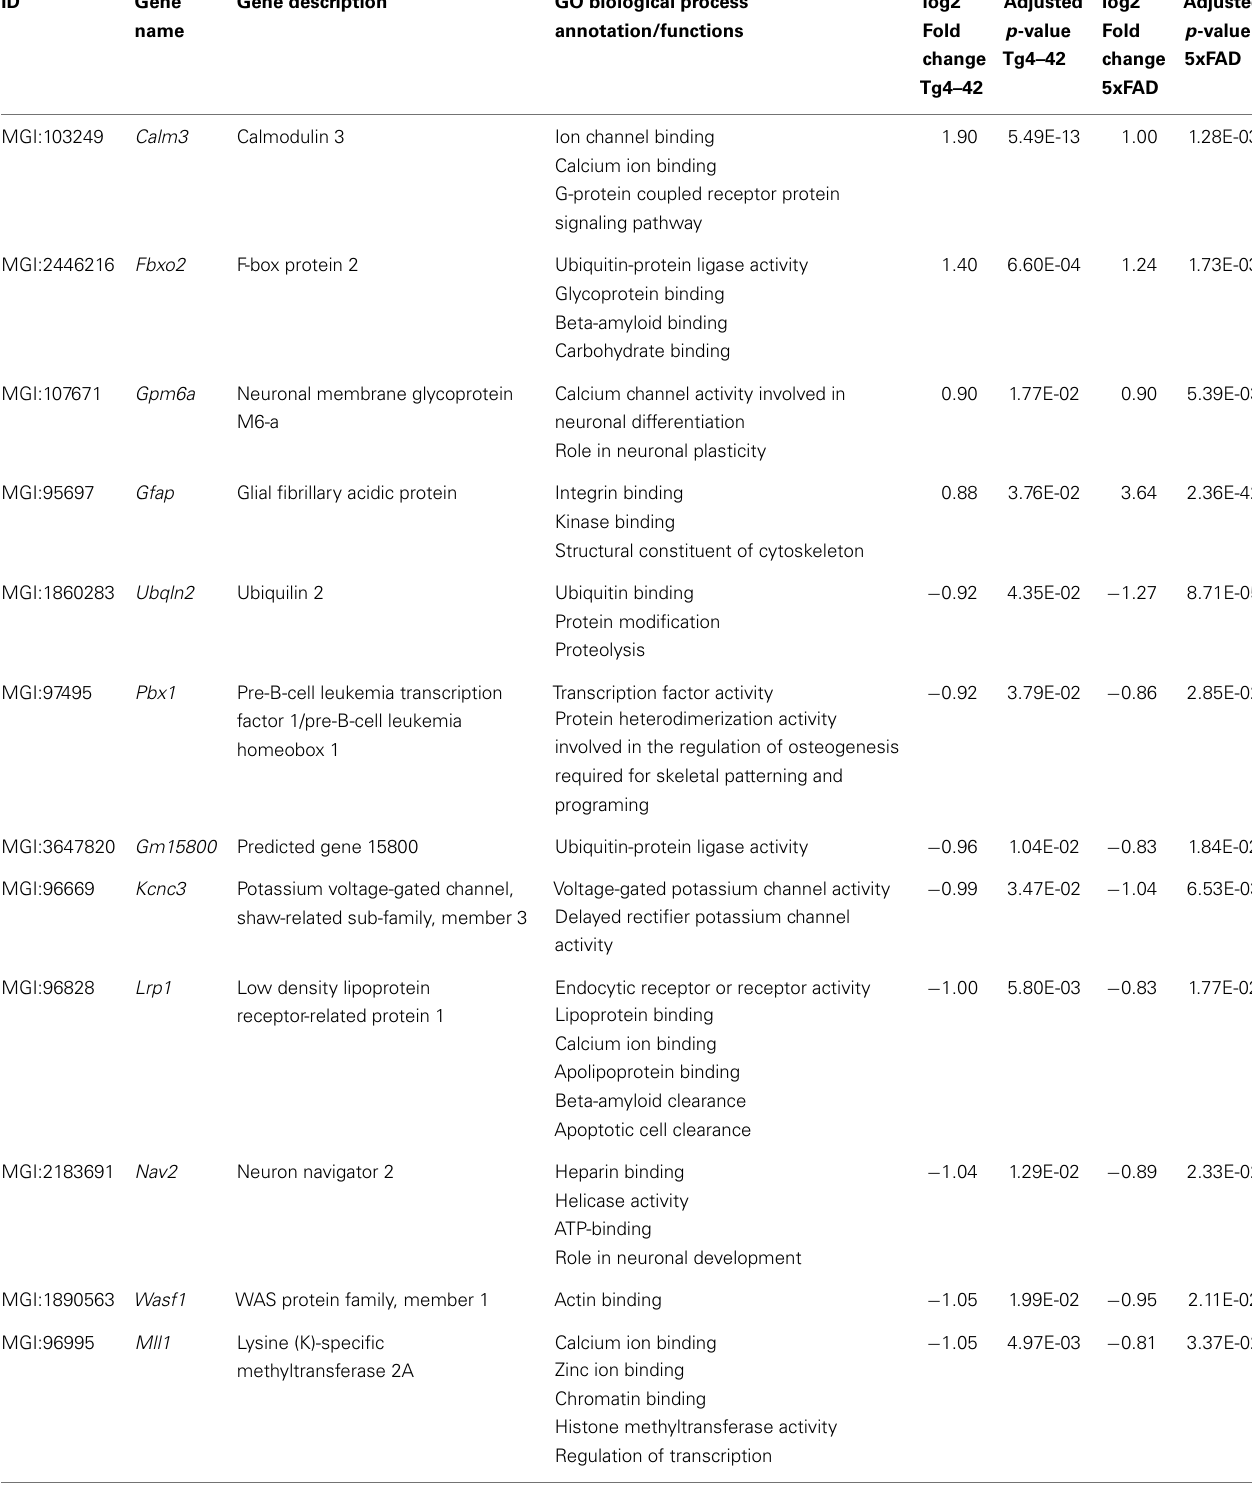
Table 4 | List of transcripts differentially expressed in both agedTg4–42 and 5XFAD